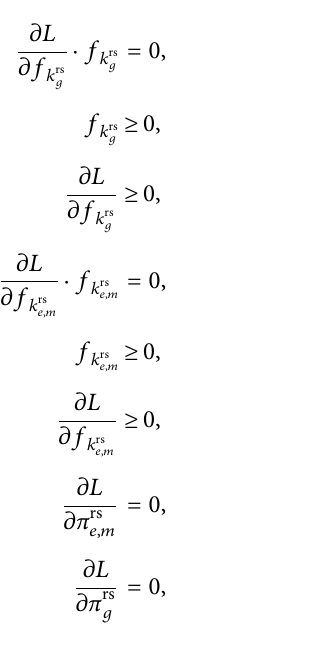
3.6. Solution Algorithm Design. Tis paper uses the